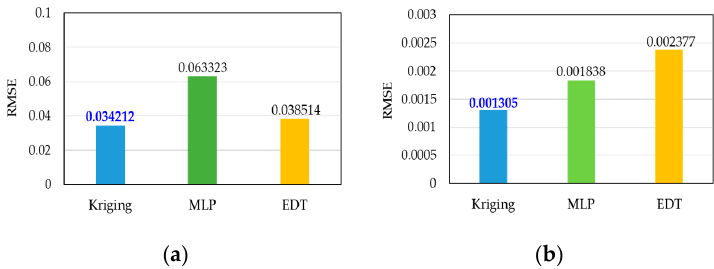
Figure 7. Root-mean-square error (RMSE) test results of metamodels for the objective function: ( a ) Efficiency; ( b ) Cogging torque.